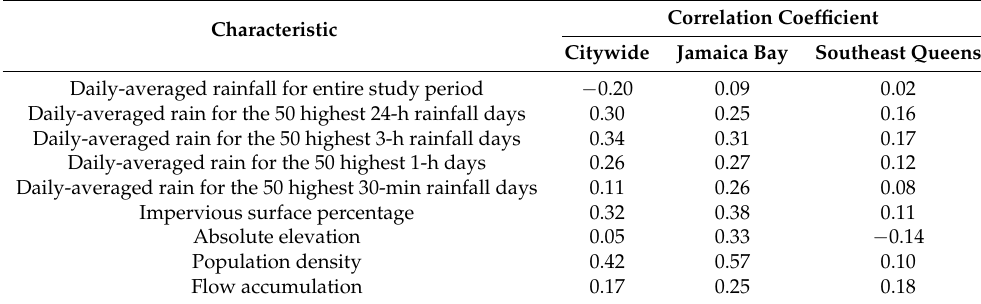
Table 2. Flooding correlations between number of flood events and potential flood